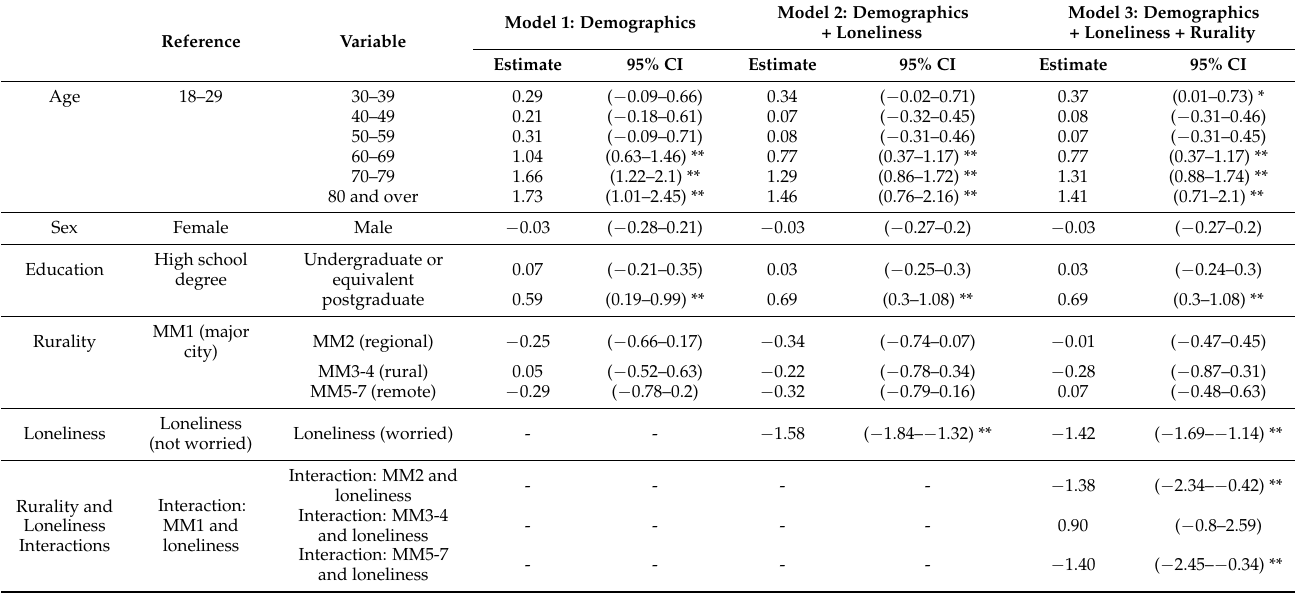
Table 2. General linear regression modelling of factors associated with happiness.